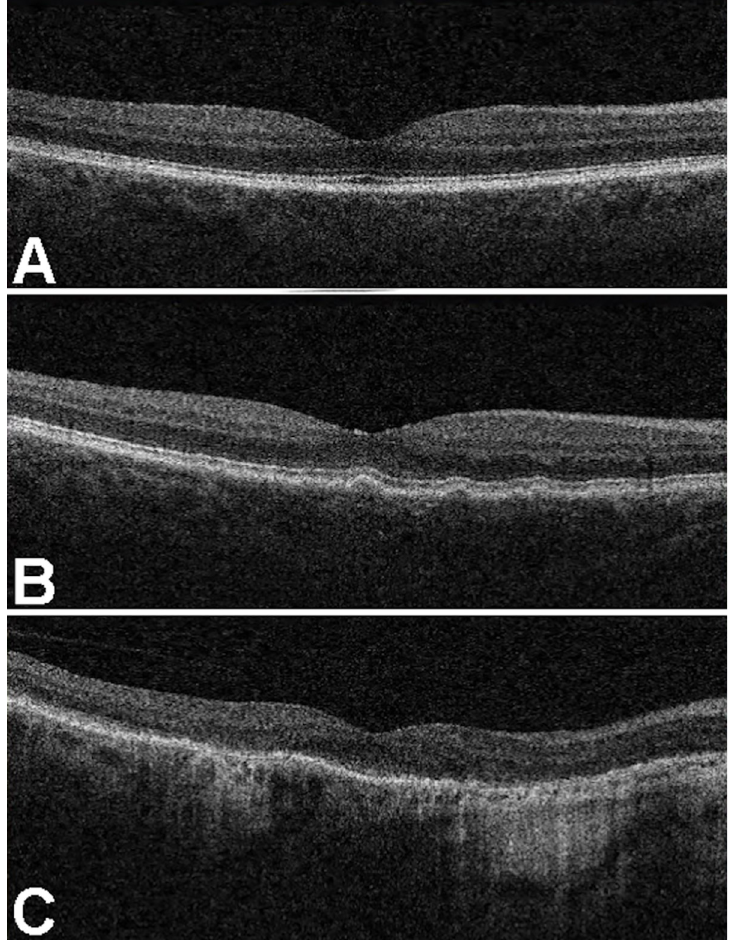
Fig 2. Optical coherence tomography grading. Examples of optical coherence tomography scans grading: images graded as score 0 (A), score 1 (B) and score 2 (C).